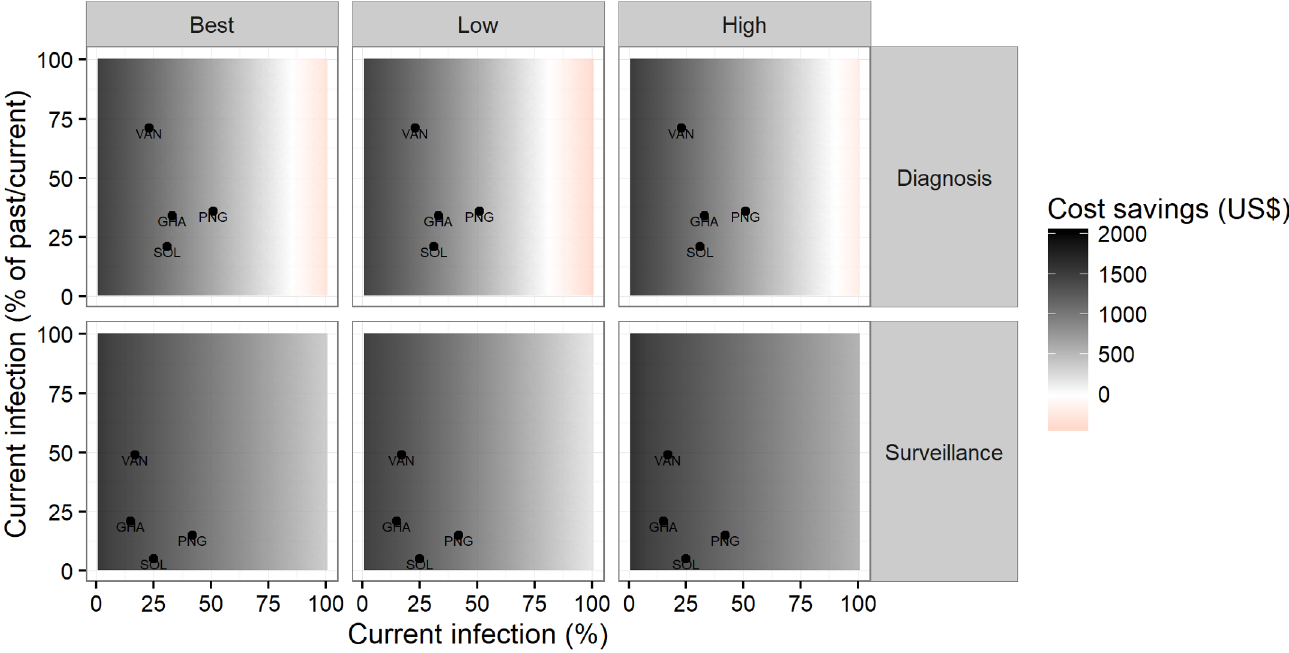
Fig 4. Cost savings of the sequential testing strategyacross different scenarios of prevalence, per 1000 people tested, by use case. Best— best estimate (median); Low—lowestimate (2.5th centile); High—highestimate (97.5th centile); cost savings are expressedper 1000 peopletested.